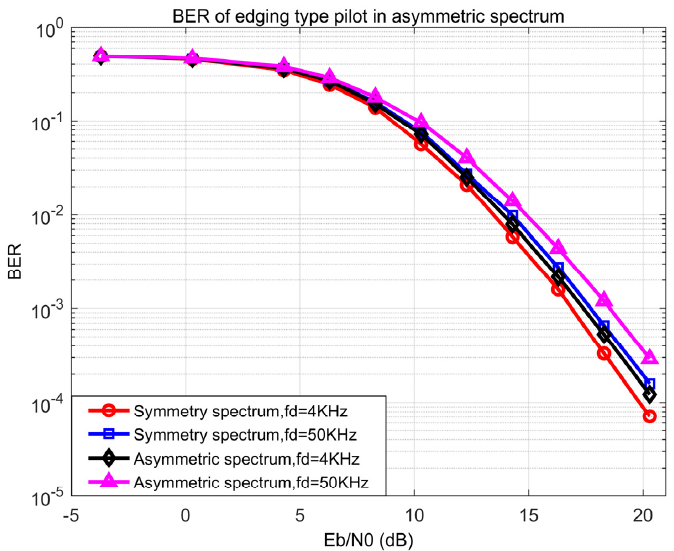
Figure 9. BER of edging type pilot in symmetric and asymmetric spectra.